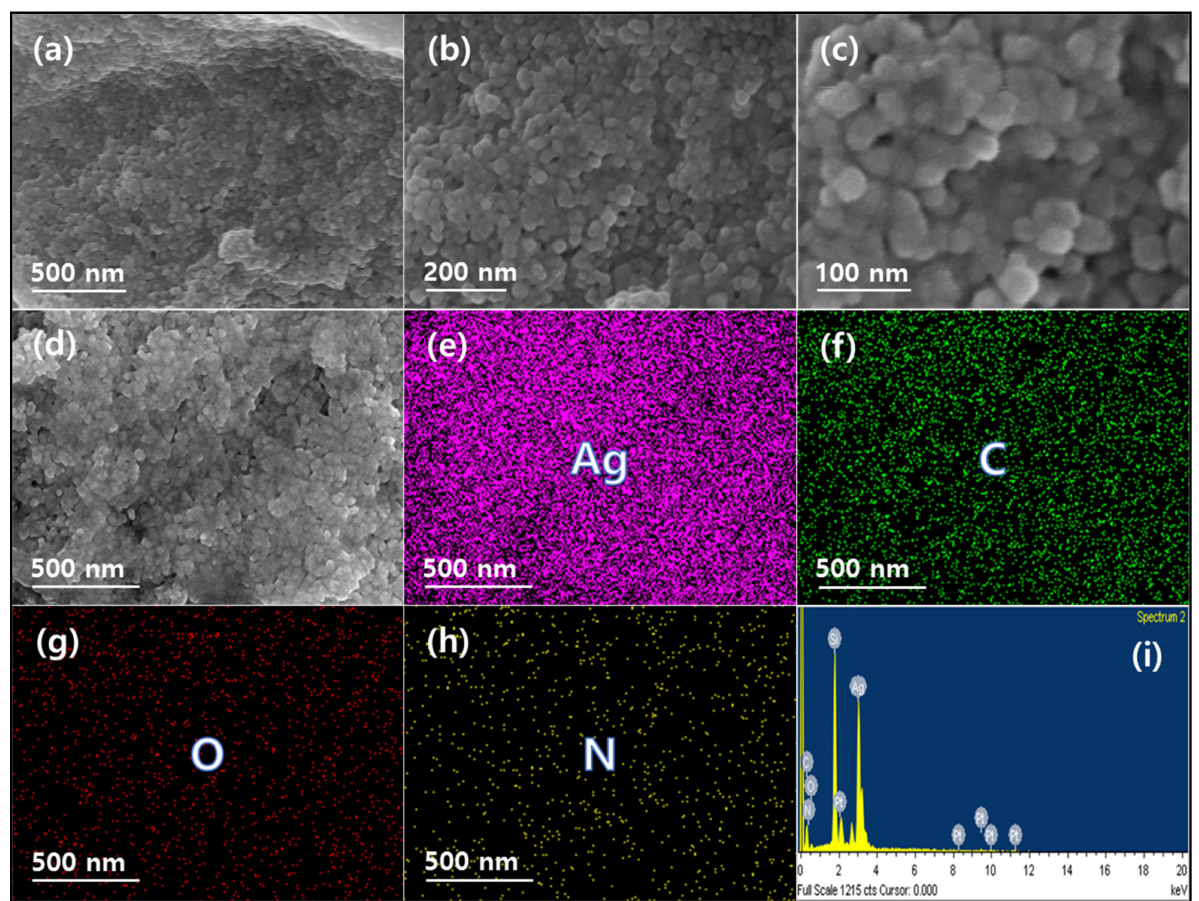
Figure 3. FESEM studies of AgNPs. ( a – d ) FESEM images with different magnifications of prepared AgNPs and the corresponding elemental mapping of ( e ) Ag, ( f ) C, ( g ) O, ( h ) N. ( i ) EDX spectrum of prepared